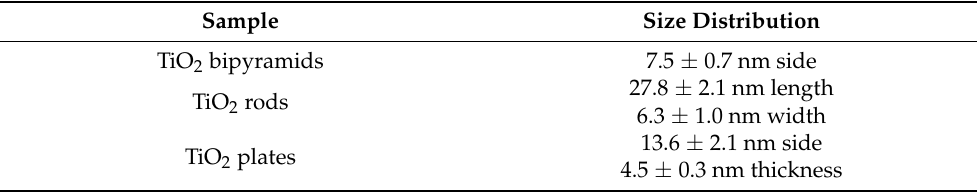
Table 1. Dimensional characterization of TiO 2 NPs administered to mice.